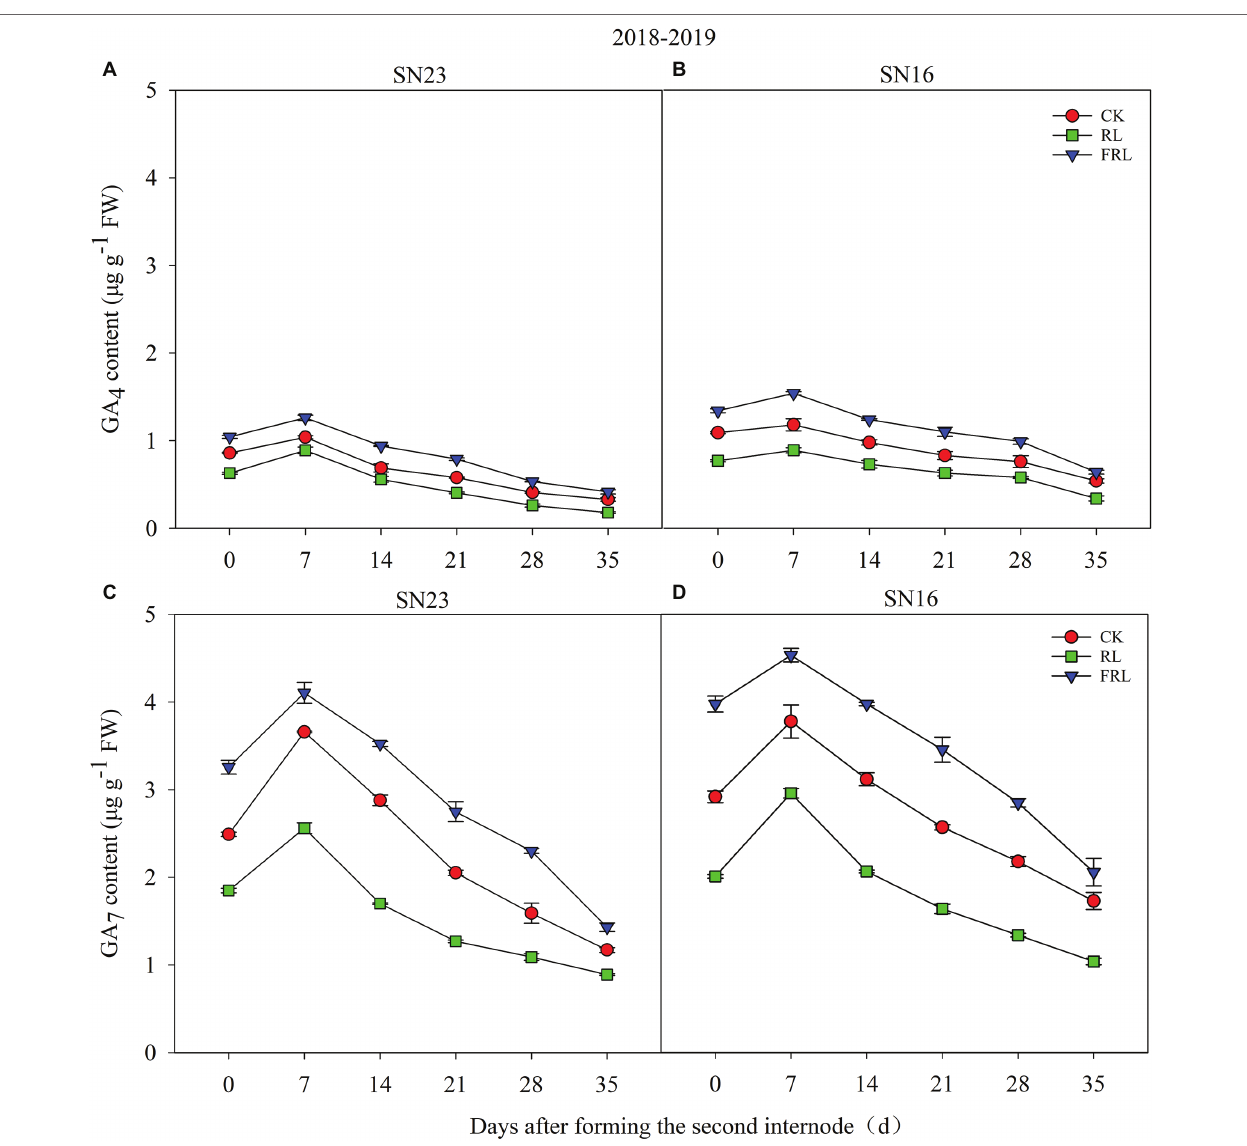
FIGURE 3 | The effect of light quality in population on GA4 (A,B) and GA7 (C,D) in wheat in 2018–2019 growing seasons. SN16 and SN23 represent the lodging- sensitive cultivar Shangnong16 and the lodging-resistant cultivar Shangnong23. CK represents the normal light, RL represents the red light, and FRL represents far-red light. Vertical bars above mean values indicate SDs ( n = 3). Means show significant differences between treatments according to the LSD ( p <